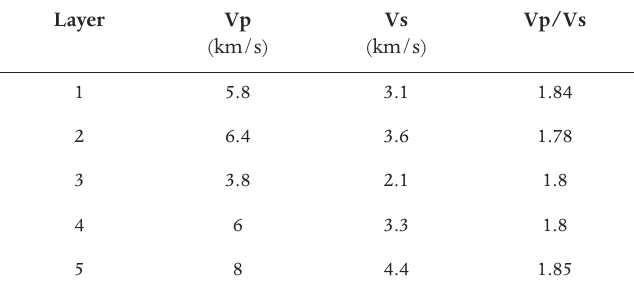
Table 2. Three-dimensional model parameters. P and S velocities, and their ratios, as illustrated in Figure 2.